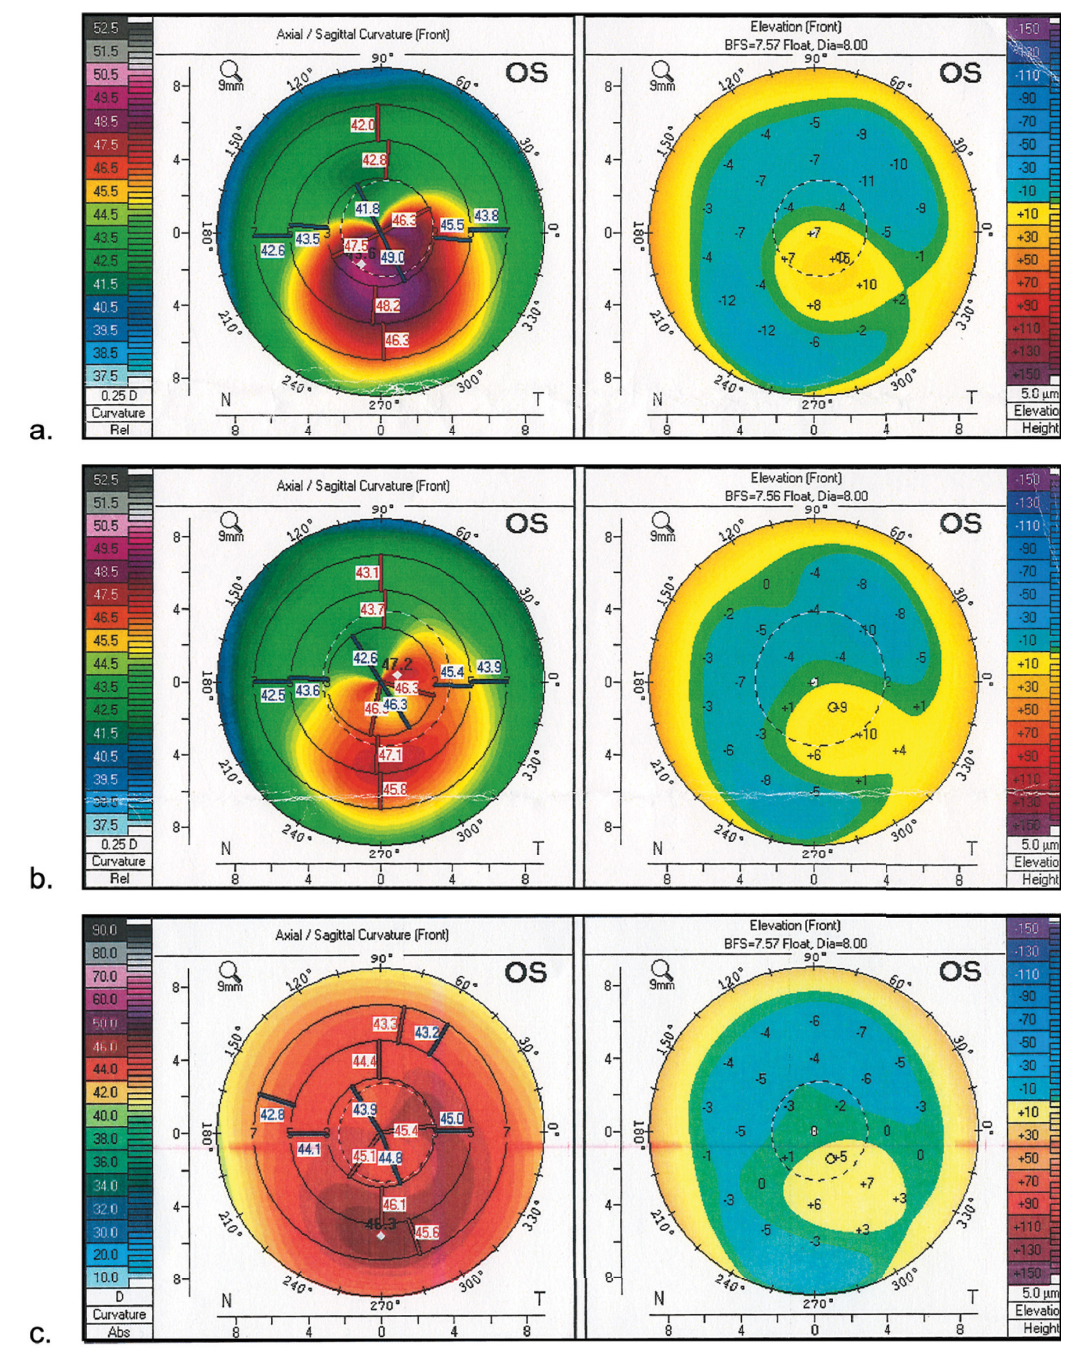
Fig 1. Pentacam sagittal curvature (front) and elevation (front) maps in patient from CXL+TG-PRK group: a. initial keratometric maps; b. keratometric maps after CXL; c. keratometric maps after CXL+TG-PRK. CXL = corneal collagen cross- linking; TG-PRK = topography-guided photorefractive